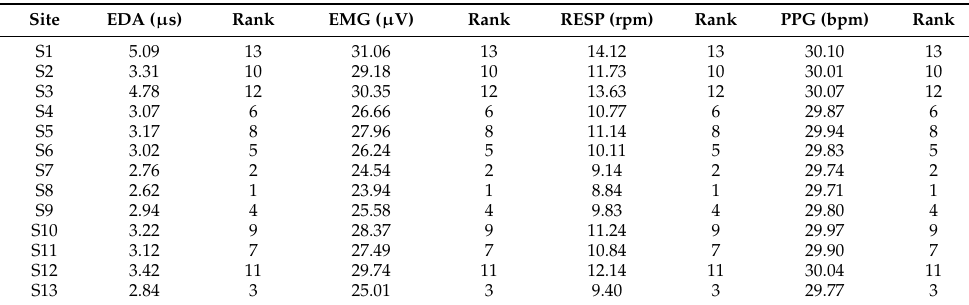
Table 3. Results of EDA, EMG, RESP, and